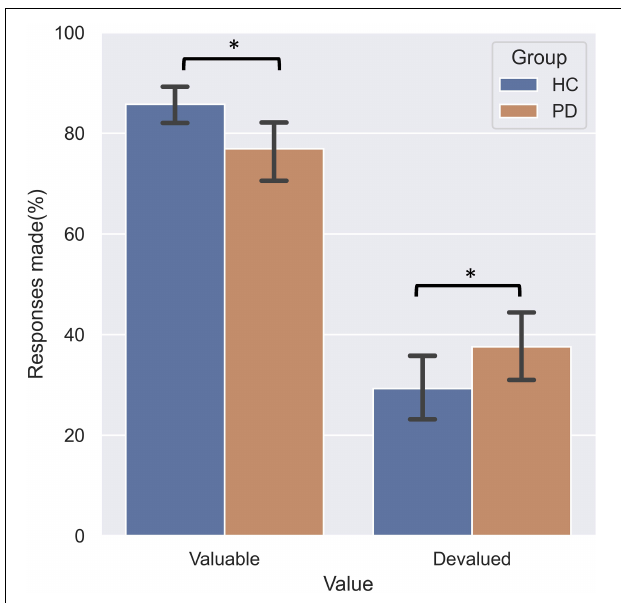
FIGURE 3 | Performance on the slips-of-action test. PD patients responded significantly less for responses associated with valuable outcomes relative to HC, and more often for outcomes that were